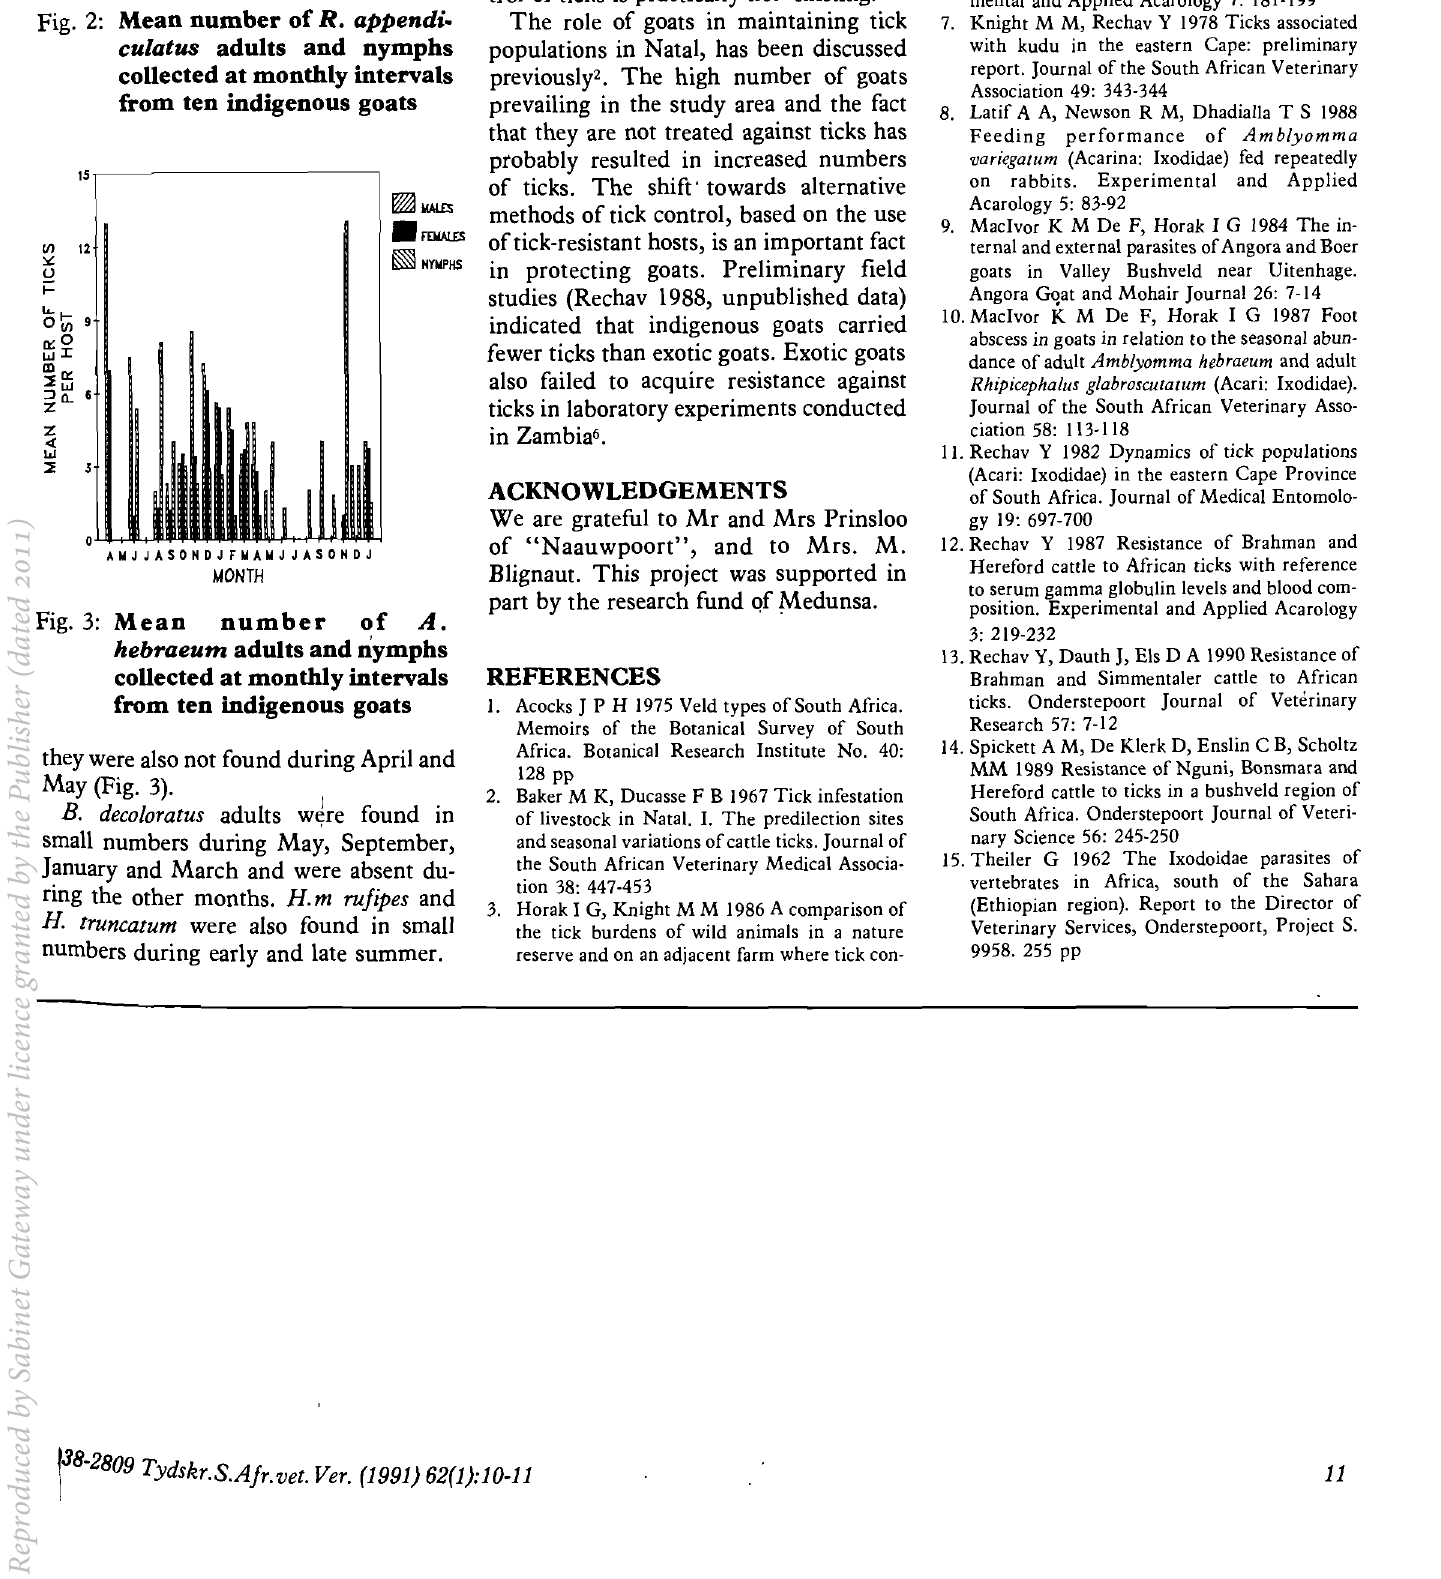
Fig. 2: Mean number of R. appendi. culatus adults and nymphs collected at monthly intervals